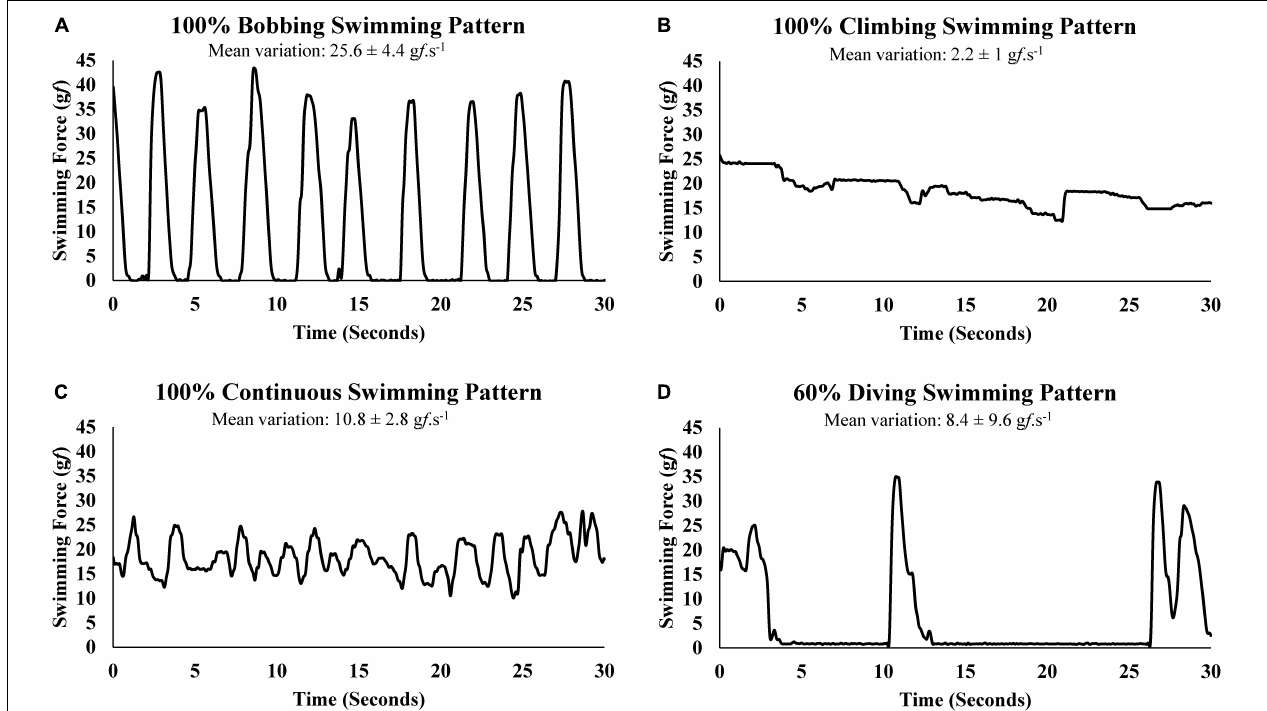
FIGURE 2 | Swimming force variation (g f .s − 1 ) of swimming patterns: (A) bobbing, (B) climbing, (C) continuous, (D) diving.